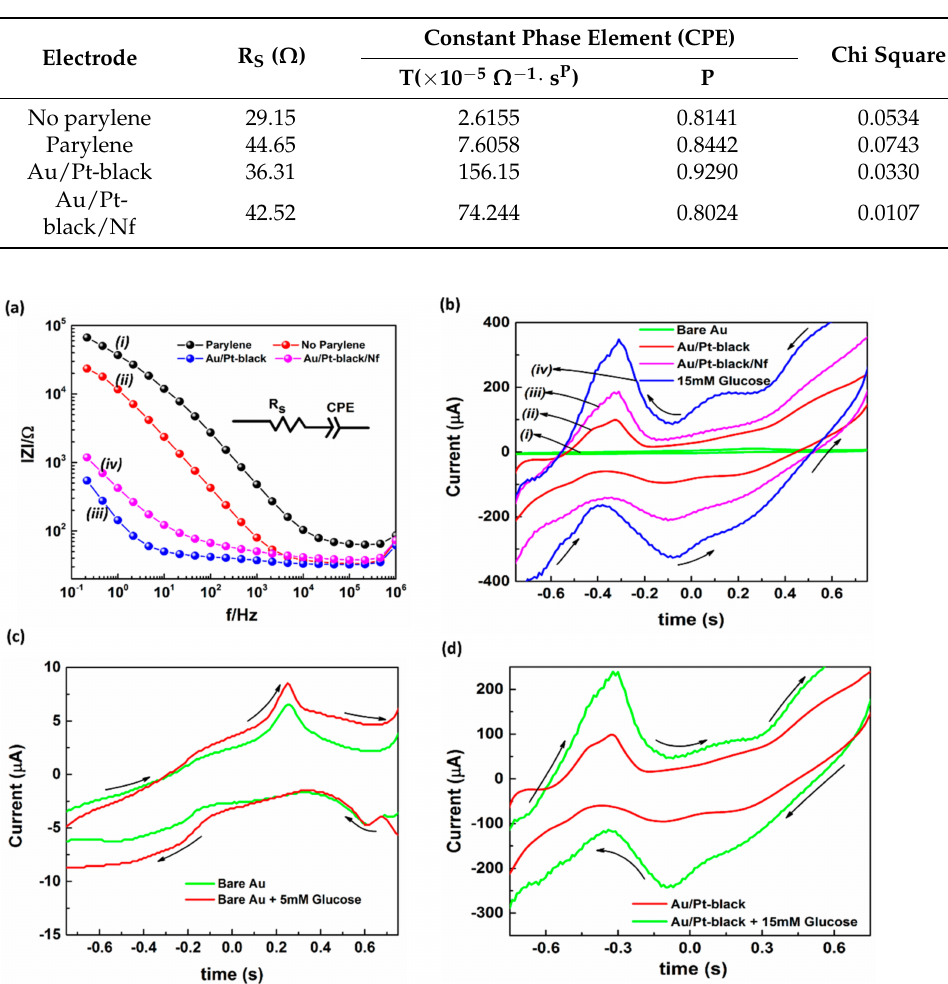
Table 1. Electrochemical impedance spectroscopy (EIS) parameters of the unmodified and modified MNEAs extrapolated by fitting the measured spectra with the equivalent circuit model as shown in Figure 5a.